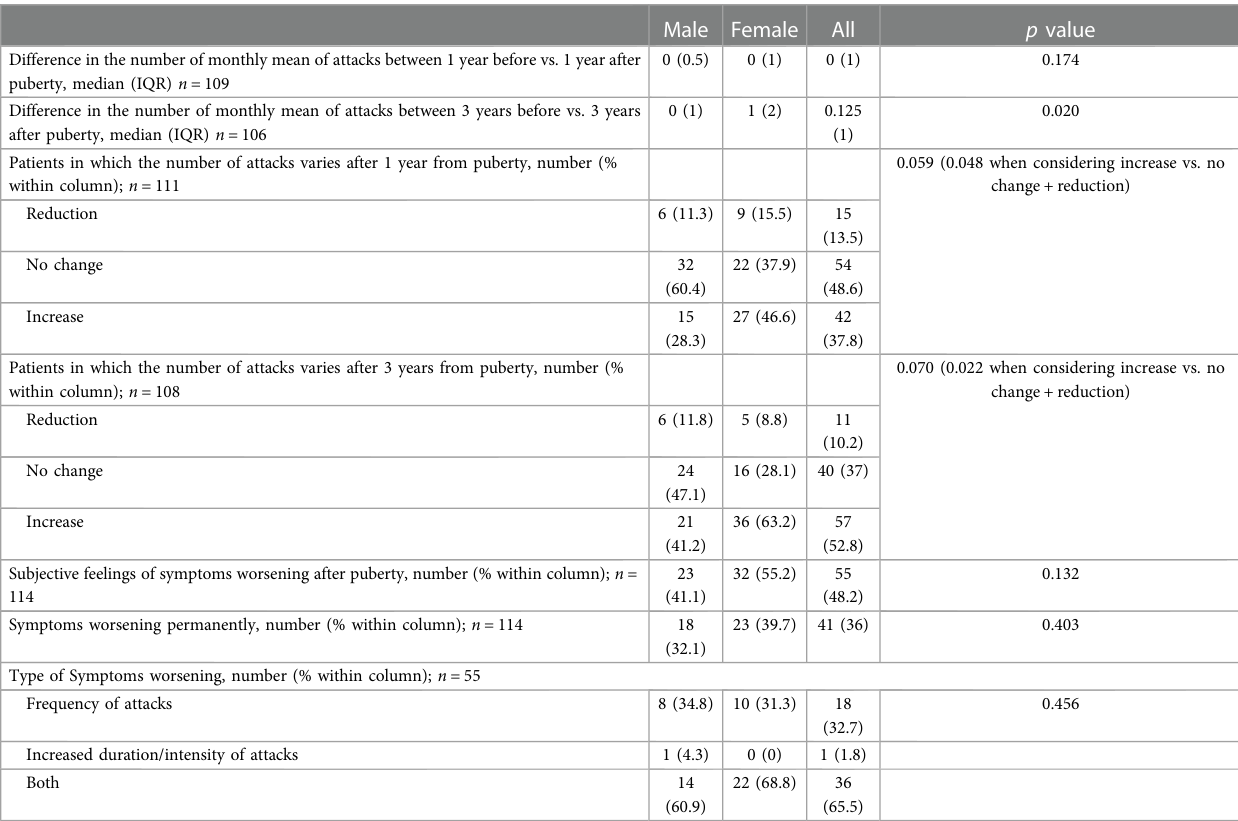
TABLE 4 Overall impact of puberty among male and female